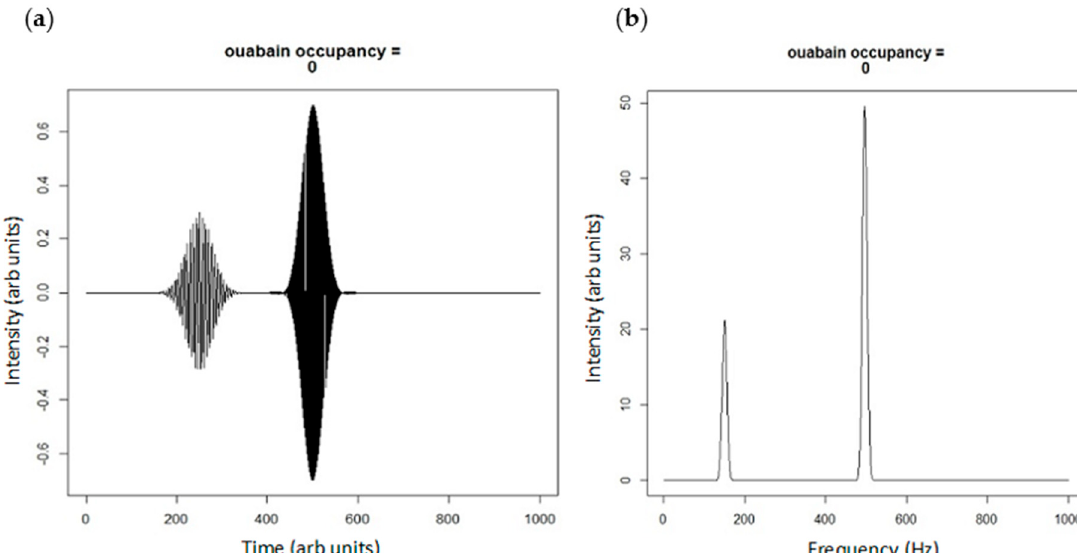
Figure 3. ( a ) Real projection of superposition of spatially (500 vs. 250 arb units) and frequency (500 vs. 150 Hz) distinct portions of Na/K-ATPase; and ( b ) the power spectrum of the Fourier transform of the plane waves in Figure 3a showing portions of signaling and pumping Na/K-ATPase. The peak at 150 Hz could be considered a net Src inhibition according to our model.